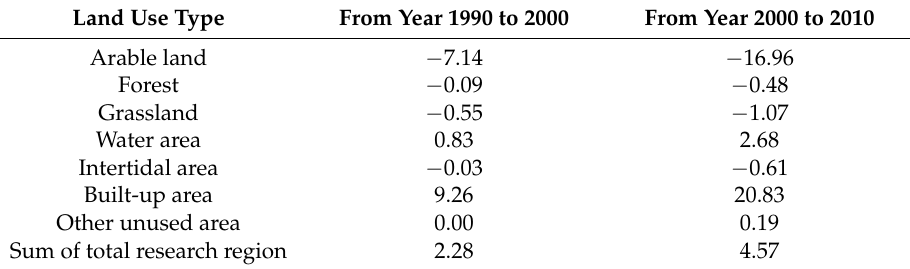
Table 6. Land use degree of Jiangsu